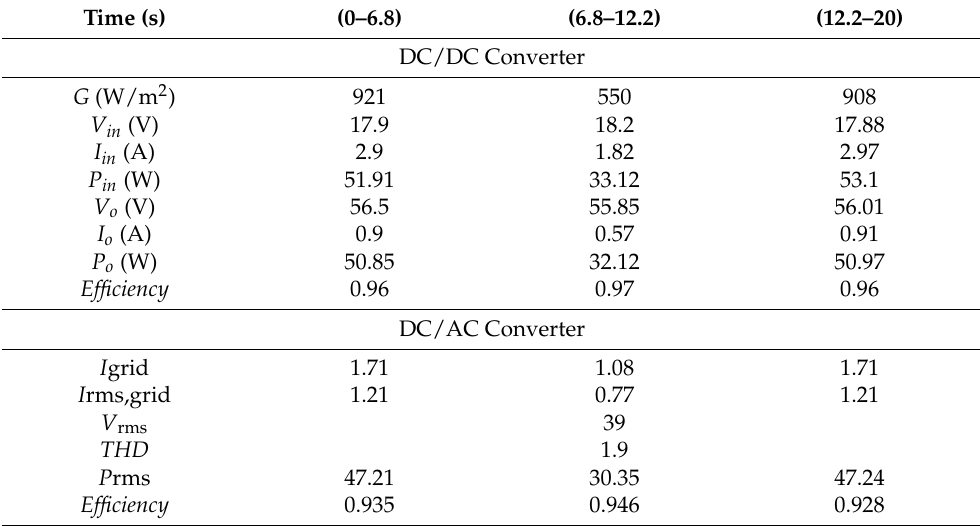
Table 1. Summary of the values of the experimental